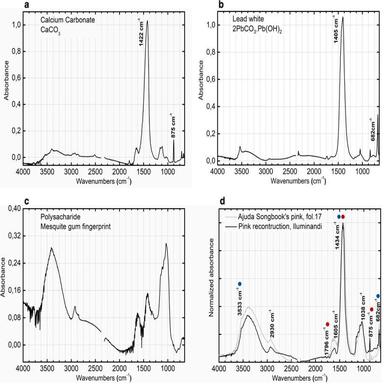
The paint formulation disclosed by infrared spectroscopy. The spectra of a) calcium carbonate (filler), b) lead white (pigment) and c) a polysaccharide (binding medium) were acquired in books of hours. They allow to better understand the complexity of the full formulation reproduced following a medieval recipe and compared with d) the light pinks found in Ajuda Songbook; components in formulation are marked as it follows lead white ( ), calcium carbonate ( ) and binder (grey line). For more details please